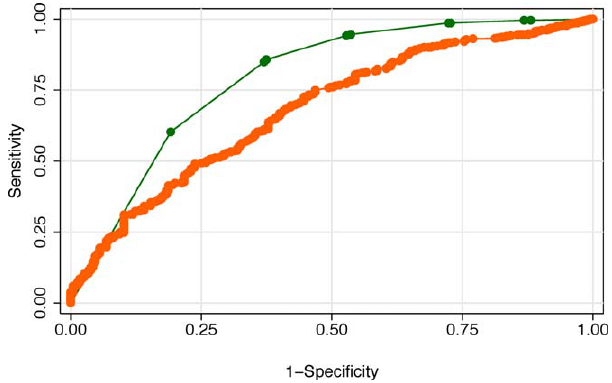
Figure 6. ROC Curve for Adherence and CD4 Count Change when Used to Identify Patients with Virologic Failure at 6 Months after cART Initiation Green and orange dots are observed adherence and CD4 þ T cell count change values, respectively. Thus, the graphs represent the sensitivity and specificity that would result if each observed adherence or CD4 þ T cell count change value were used as a diagnostic test for current virologic failure. The AUC was 0.79 (95% CI 0.76–0.83) for adherence and 0.68 (95% CI 0.64–0.72) for CD4 count change ( p , 0.001, Chi-square test).